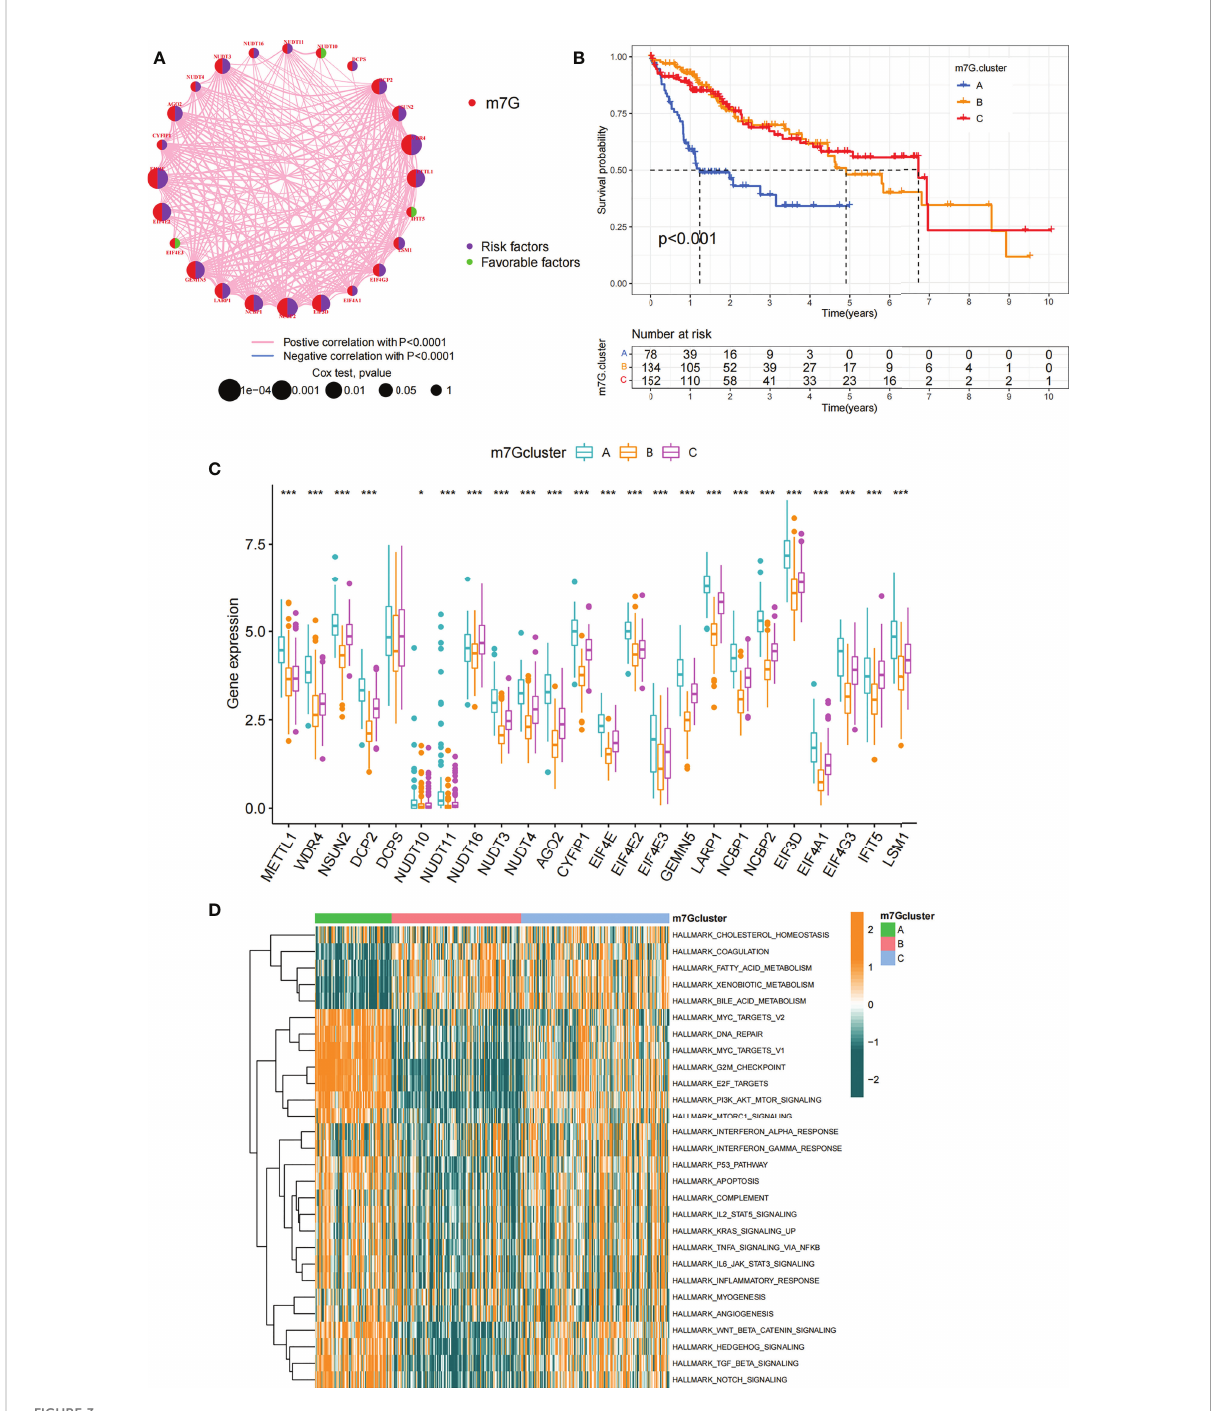
FIGURE 3 m 7 G modi fi cation patterns and related biological pathways. (A) Interaction of 24 m 7 G regulators expressed in HCC. The size of every circle indicated the prognostic effects of individual regulators and scaled by p-value. m 7 G regulators, red; favorable factors, green; risk factors, purple. (B) Survival curve for survival of 364 HCC patients in TCGA-LIHC cohort of different m 7 G clusters. The numbers of patients in m 7 G cluster A, B, and C are 78, 134, and 152, respectively. (C) Comparing the expression of 24 m 7 G regulators between three m 7 G clusters. (D) GSVA enrichment analysis displaying the activation status of biological pathways with different m 7 G clusters. The heatmap was made to visualize these biological processes, with yellow representing activated pathways and green representing inhibited pathways. Asterisks represent statistical p-values (*P < 0. 05; ***P < 0.